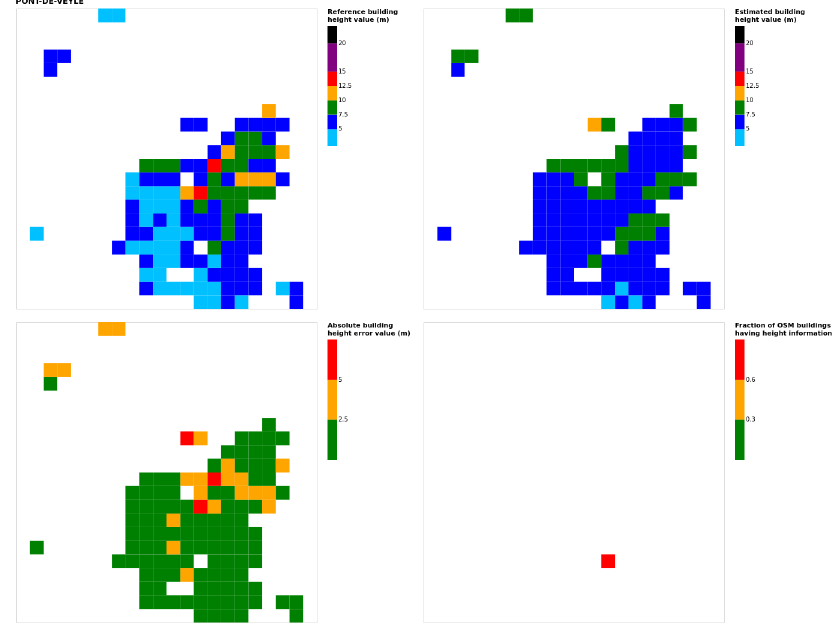
Figure B18. Results for the commune at grid cell (upper left panel) reference building height, (upper right panel) estimated building height, (lower left panel) absolute building height error, and (lower right panel) fraction of OSM buildings that have height information. For all panels except the lower right, only cells that have buildings – with at least 90% of their buildings having no height value in OSM – are